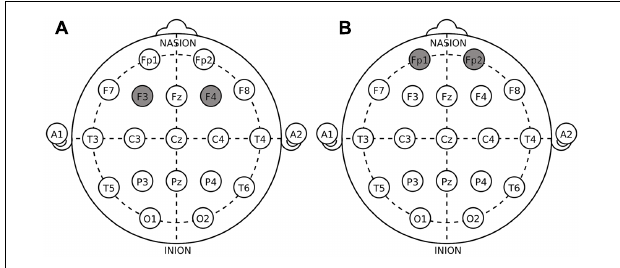
FIGURE 1 | Electrode placements in dorsolateral prefrontal cortex (DLPFC) stimulations (A) and orbital frontal cortex (OFC) stimulations (B) .